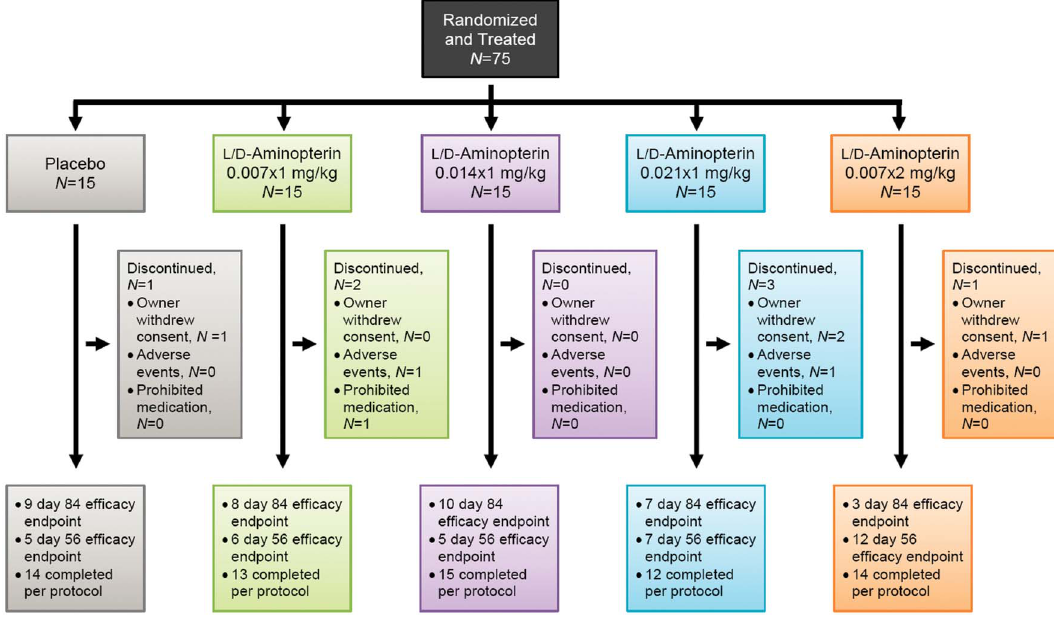
Figure 3. Disposition of subjects. A total of 68 subjects (91%) completed the study per protocol. Discontinuations (9%) were for withdrawal of owner consent ( N =2), owner perceived AE ( N =2), and prohibited medication ( N